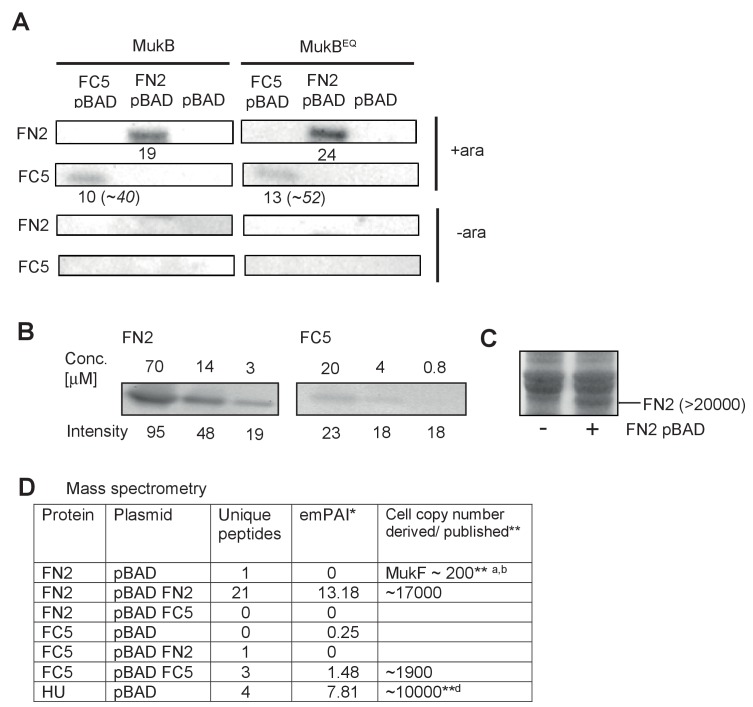
Expression levels of FN2 and FC5 after arabinose-induced induction.(A) Western blot analysis of overexpression levels of MukF fragments FN2/FC5 in whole cell protein samples from arabinose induced and uninduced mukB and mukBEQ cells, as above. Relative intensities of bands (after background subtraction) are shown under the bands. In italics (parentheses) are the corrected intensities for FC5 after taking into account the different specific binding activities of FN2 and FC5 to the MukF antibody (B). We therefore estimate a ~2 fold excess of FC5 monomers over FN2 dimers in both mukB and mukBEQ cells. (B) Titration of purified FN2 and FC5 proteins against the same MukF antibody to determine the relative specific activity of detection of FC5/FN2. We estimate that the signal is ~4 fold less per FC5 monomer than a FN2 dimer. (C) SDS PAGE of proteins from lysates produced from induced cells lacking or carrying induced pBAD FN2. Since E. coli contains >1×106 protein molecules and semiquantitative scans of the gel lanes showed FN2 to represent ~2% of cell protein after arabinose induction, we estimate the copy number of FN2 dimers to be >20000 (parentheses), with none detectable before induction. (D) Quantitative mass-spectroscopy analysis of overexpression levels of MukF FN2 and FC5 fragments. The values represent two replicates from a single representative experiment. emPAI was used to estimate copy number/cell with HU alpha as a standard. The low relative value here for FC5 compared to FN2 in relation to the values in panel A is likely a consequence of FC5 yielding few peptides; we therefore conclude that the values in panel A are more robust. Nevertheless, the value here for FC5 is still in ~10 fold excess of endogenous MukF. *emPAI - Exponentially Modified Protein Abundance Index (Ishihama et al., 2005); a microscopic determination in live cells (Badrinarayanan et al., 2012a); b Western blot analysis (Petrushenko et al., 2006b); dhttps://pax-db.org/protein/6884531.